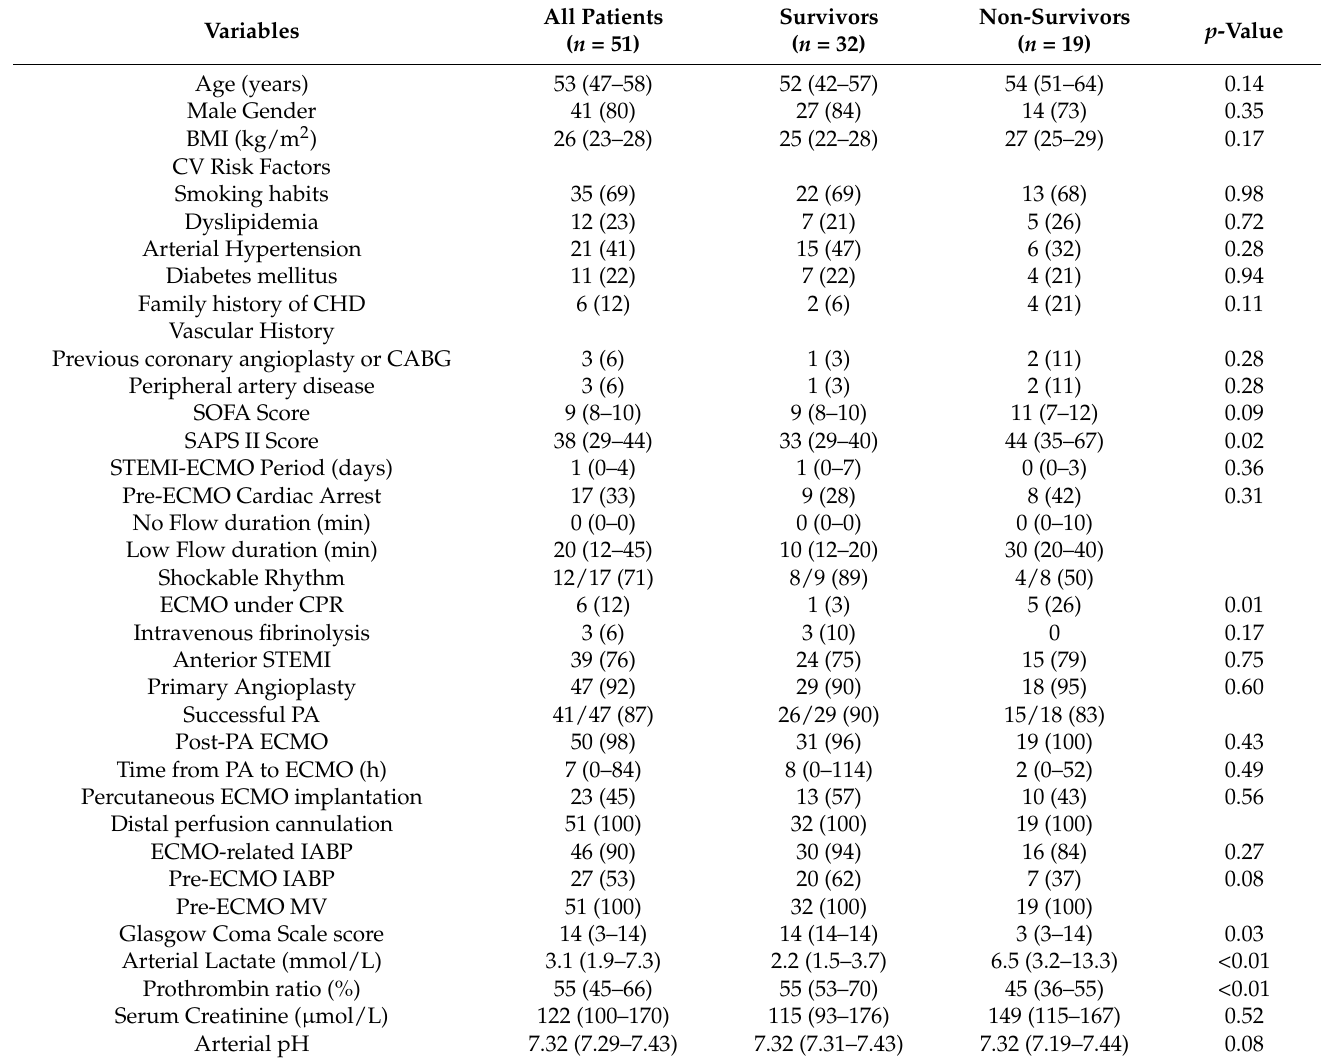
Table 1. Patient characteristics according to the Intensive Care Unit (ICU) survival